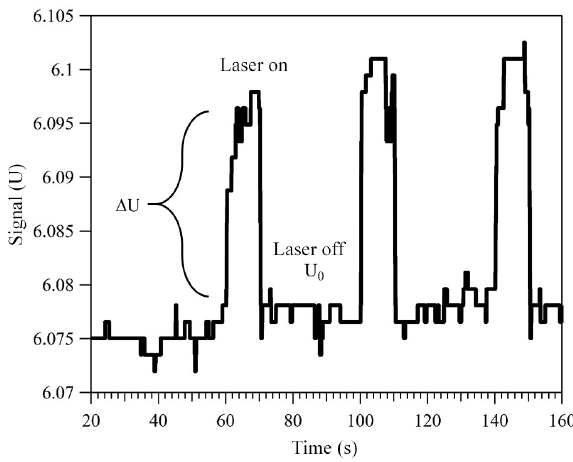
Figure 2. Change in the applied DC voltage in response to alter- nately illuminating a trapped light-absorbing particle. Here, a par- ticle with 12.72µm radius and κ ≈ 1 . 36 × 10 − 4 was levitated in 400mbar of dry nitrogen. For more details on how the particle size and imaginary part of the CRI were determined, refer to Sects. 2.2 and